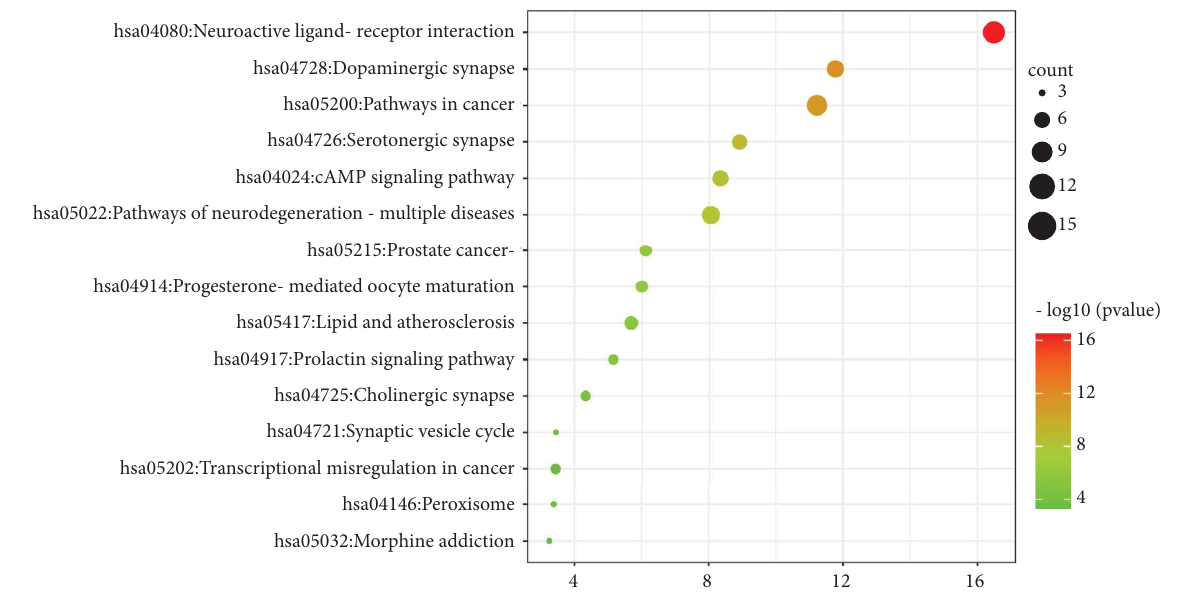
Figure 5: KEGG enrichment analysis